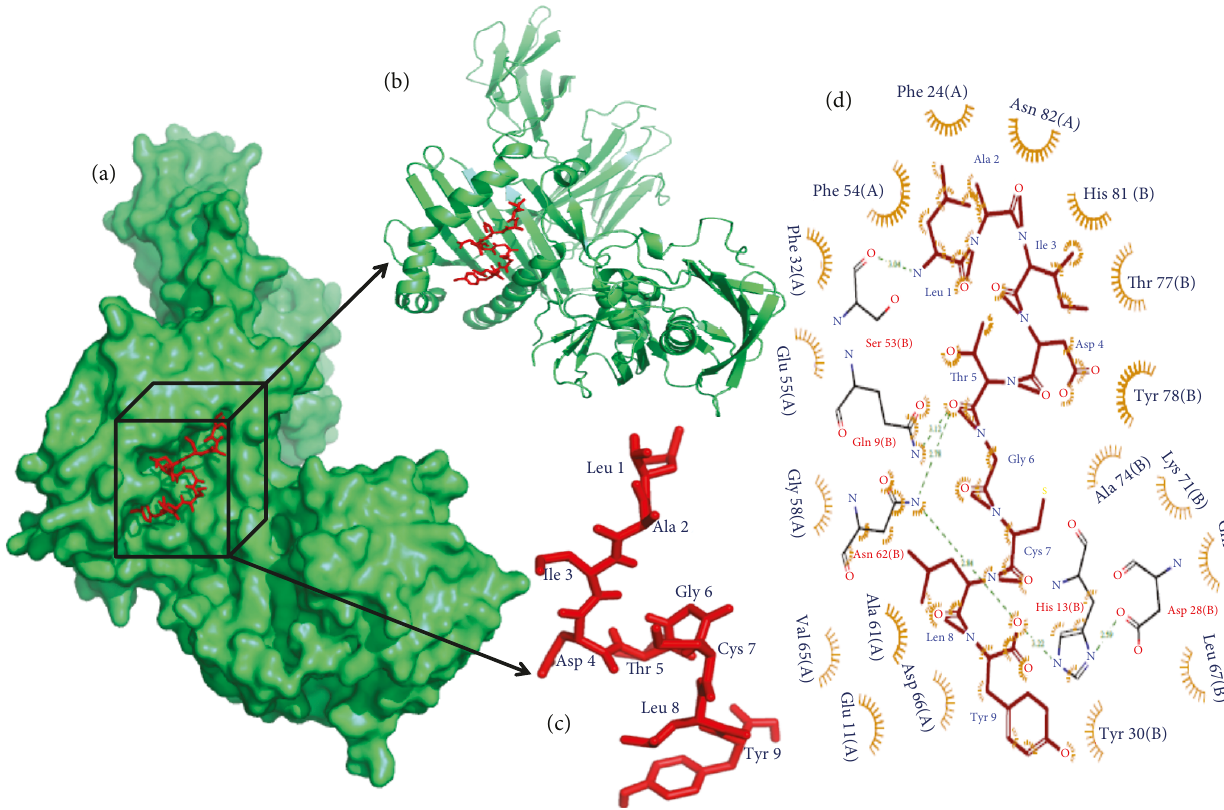
Figure 4: Docking simulation study. (a) The docking results as the surface structure of the MHC-II (HLA-DR) (lime green color) and the sticky form of epitope “ LAIDTGCLY ” (red color). Black color box represents the position of epitope in the surface structure. (b) Epitope in the cartoon structure. (c) Sticky form of epitope “ LAIDTGCLY ” (red color) with residue position. (d) Binding interaction of the epitope residues and the HLA-DR residues through the hydrogen bonds. Hydrogen bonds and the distances are shown in green